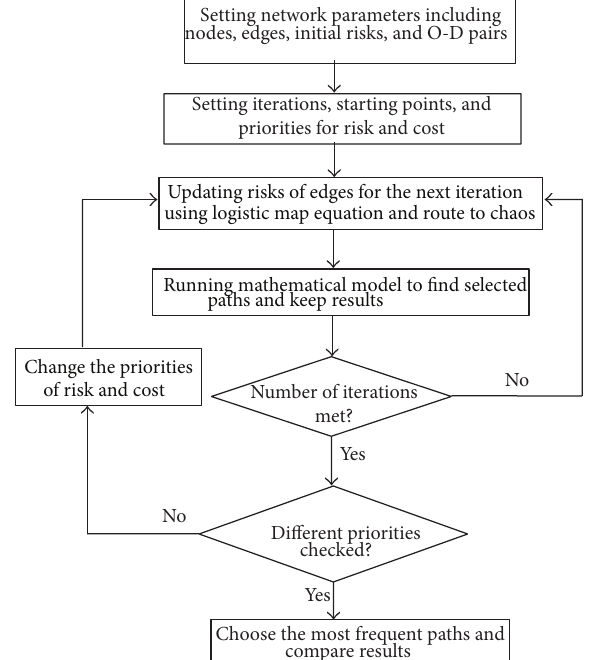
Figure 1: Overall view of the proposed